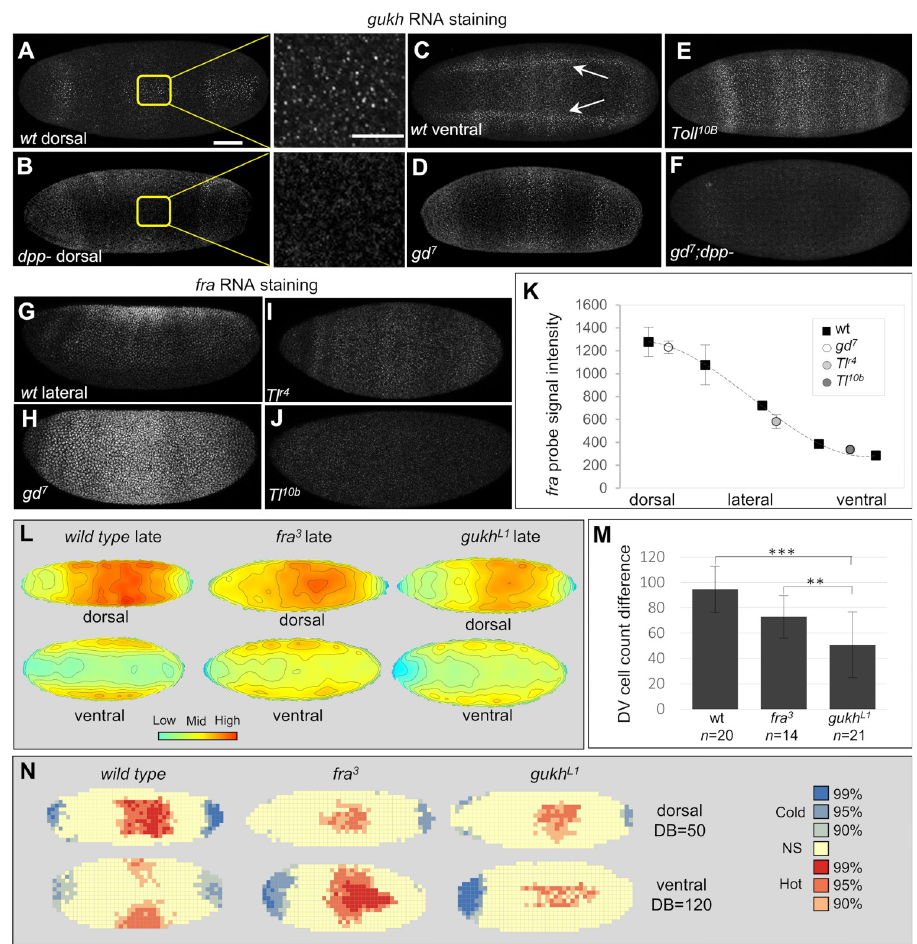
Fig 3. GUKH and FRA are DL and/or DPP targets that regulate coordinated cell movements. (A–F) gukh is activated by DPP and DL. In the wild type (wt), gukh RNA appears in a thin stripe in the dorsal midline (A) and a broad ventral domain with high levels in the ventral neuroectoderm (C, arrows; S1 Fig). (B) gukh dorsal expression is lost in dpp- embryo; compare nascent transcripts in insets in A, B (see also S1 Fig). (D) gd 7 mutant without DL and ubiquitous DPP have expanded gukh dorsal domain across the D/V axis and loss of neuroectodermal expression domain. (E) Toll 10b mutant with ubiquitous high nuclear DL levels have gukh ventral expression domain expanded. (F) gukh expression is completely lost in the absence of DL and DPP in gd 7 ; dpp- . (G) fra RNA forms a D/V gradient. Graded DL levels repress fra as seen by fra expansion in gd 7 mutant with no DL (H) and increasingly lower levels in Tl r4 (I) and Tl 10b (J) mutants with intermediate and high nuclear DL levels (see also S1 Fig). (K) fra RNA levels decrease with increasing levels of DL in wild type and in mutants. (L) Average cell density heatmaps of late-stage wild type, fra 3 and gukh L1 embryos ( n = 9) show that the high cellular density in the dorsal side requires fra and gukh . Note also the higher ventral cellular density in the mutants compared to wild type (see also S2 Fig). (M) D/V cell count differences of genotypes in (L). Error bars, standard deviation. Asterisks, threshold values based on p -values calculated with two-tail Mann–Whitney test ( �� p < 0.001 and ��� p < 0.0001). (N) Hot spot analysis of dorsal and ventral embryo surfaces of wild type, fra and gukh . Legend on left shows color-codes for confidence intervals; NS, not significant; DB, distance band value employed for each surface analyzed. Scale bars shown in A, 60 μ m (whole mounts), 20 μ m (inset). Metadata for the graphs shown in K and M can be found at Supporting information S1 Metadata. DL, dorsal; DPP, decapentaplegic; D/V, dorso-ventral; FRA, frazzled; GD, gastrulation defective; GUKH,